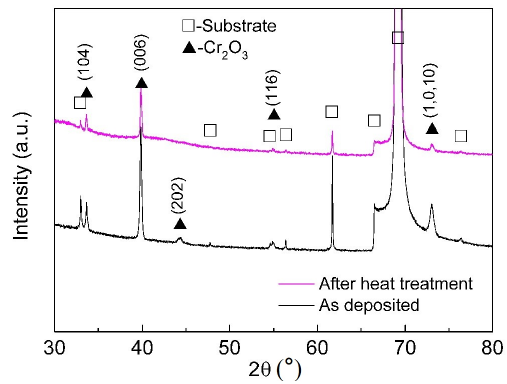
Figure 6. X ‐ ray diffraction spectrum of the Cr 2 O 3 film before and after heat treatment. Figure 6. X-ray diffraction spectrum of the Cr 2 O 3 film before and after heat treatment.